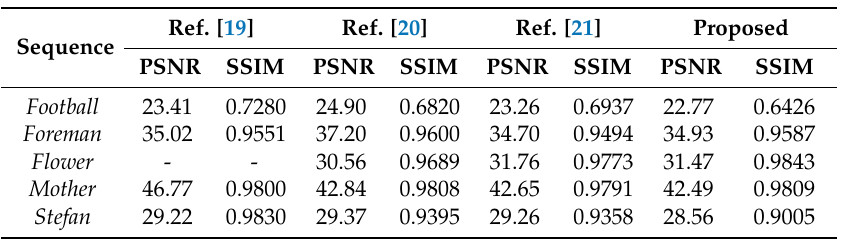
Table 4. PSNR and SSIM comparisons of different MC-FRUC methods for the test sequences. Ref. [19] Ref. [20] Ref. Sequence